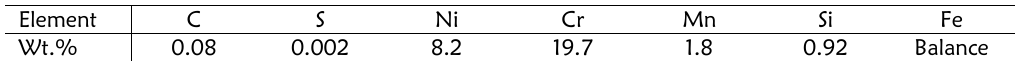
Table 1: Chemical composition of the failed wire rope.